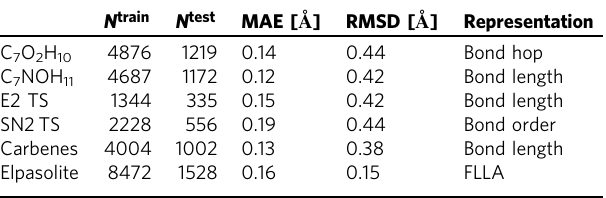
Fig. 1 Schematic of the G2S work fl ow and QM9 constitutional isomer dataset. a From left to right: molecules in the training set are separated into heavy atoms and hydrogens and featurized with a given representation. During training, one machine is used for each pairwise distance. For the prediction of new structures, only molecular connectivity is needed, which can be provided e.g. via SMILES 13 or SELFIES 14 . The machines predict all pairwise distances. The full 3D geometry is then reconstructed using DGSOL 15 for heavy atoms and a Lebedev sphere optimization scheme for hydrogen atoms. b Example isomers and distance matrix distributions of the C 7 O 2 H 10 QM9 constitutional isomer dataset. The sorting of the atoms and the distance matrix is dependent on the sorting of the molecular representation (example shown for the bond length representation). c Energy distribution and principal moments of inertia of the C 7 O 2 H 10 and C 7 NOH 11 dataset. Table 1 Accuracy of the best performing representation for each dataset at maximum training set size N train and for test set size N test speci fi